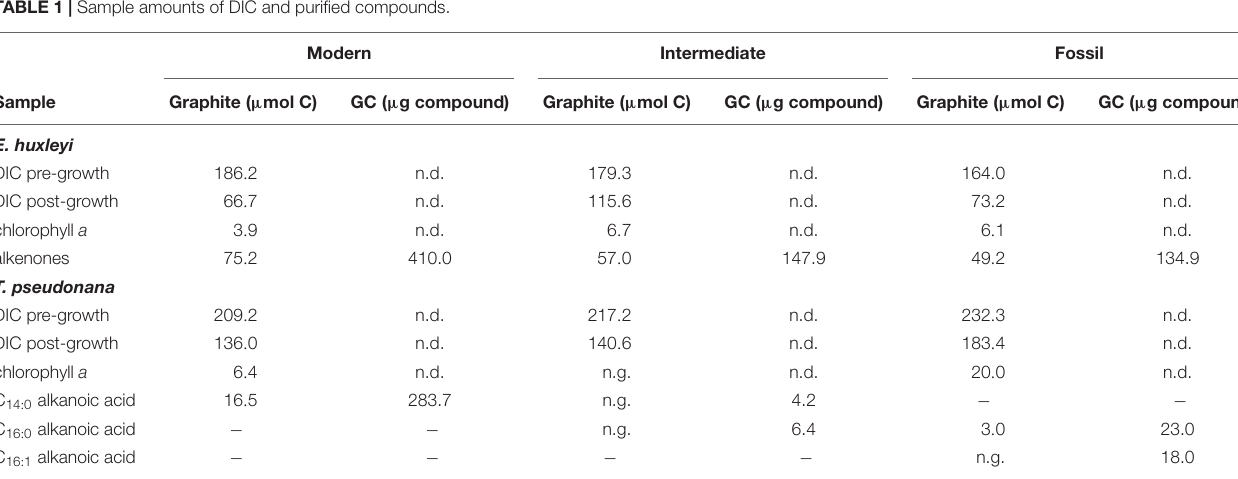
, not shown due to scale. (cid:104)